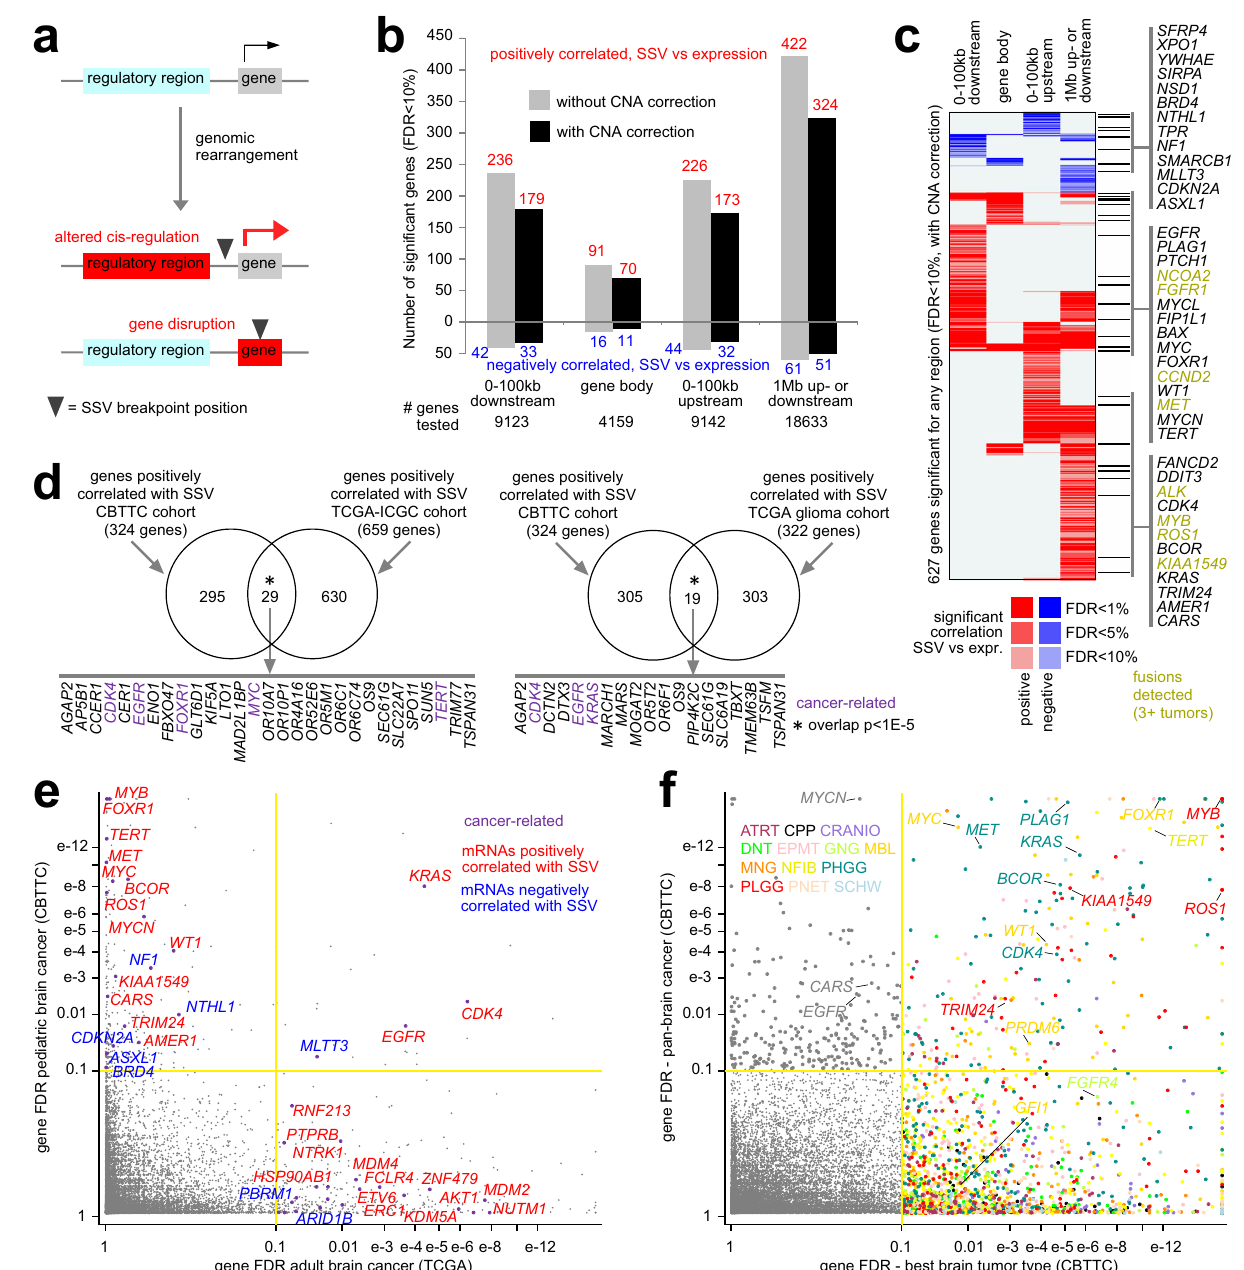
Fig. 2 Genes with altered expression associated with nearby SSV breakpoints. a Schematic of the phenomenon of interest. SSV breakpoints outside of genes may result in altered cis-regulation. SSV breakpoints within genes may involve gene disruption or fusions. b For each of the indicated genomic region windows examined, numbers of signi fi cant genes (FDR < 10%) showing a correlation between expression and associated SSV event. Numbers above and below the zero point of the y -axis denote positively and negatively correlated genes, respectively. Linear regression models evaluated signi fi cant associations when correcting for tumor type (gray) and for both tumor type and gene-level CNA (black). For the 1 Mb region window, the model weights the relative gene distances of the breakpoints 4 . c Heat map of signi fi cance patterns for 627 genes signi fi cant for any region window (FDR < 10%, correcting for both tumor type and CNA). Red denotes signi fi cant positive correlation; blue, signi fi cant negative correlation. Genes listed are cancer-associated 20 . d Venn diagrams representing the overlaps between the genes positively correlated (FDR < 10%) with SSV breakpoint in CTBBC pediatric brain cohort and the genes positively correlated (FDR < 10%) with SSV breakpoint in either TCGA-ICGC cohort (left, n = 2334 cases) or TCGA glioma cohort (right, n = 107 GBM/LGG cases). P values by one-sided Fisher ’ s exact test. e Signi fi cance of genes in TCGA glioma cohort (107 patients, x -axis), as compared to their signi fi cance in the CBTTC cohort (854 tumors, y -axis). Genes in the upper left quadrant reached signi fi cance only in the present study. f X -axis indicates the FDR in the most signi fi cant of 13 pediatric brain tumor types analyzed separately, and y -axis indicates the FDR when the 854 CBTTC tumors are analyzed as a combined cohort. Genes in the upper left quadrant reached signi fi cance only in the pan-cancer analysis. Genes in the lower right quadrant reached signi fi cance only in one or more single-type analyses. Color of data points represents the most signi fi cant tumor type. For d – f , signi fi cant genes are de fi ned by 1 Mb region window, correcting for tumor type and CNA. For d , e , “ cancer-related ” is by COSMIC 20